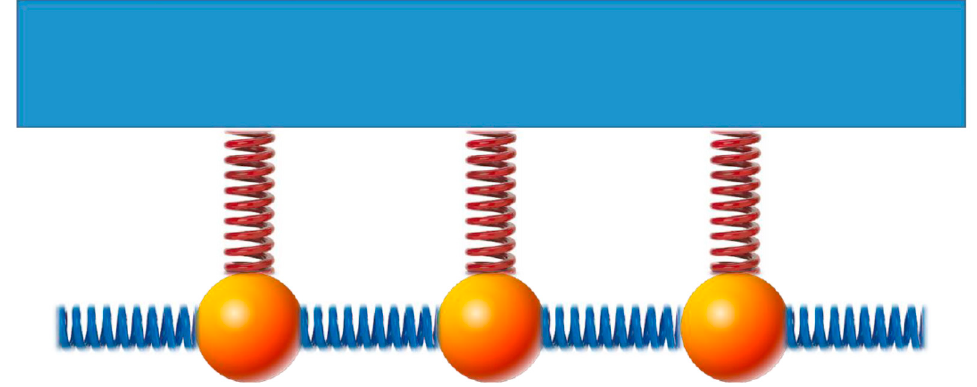
Figure 2. Schematic illustration of the harmonic chain grounded to a substrate via side springs (system in Figure 1 when (cid:1839) → ∞ ).